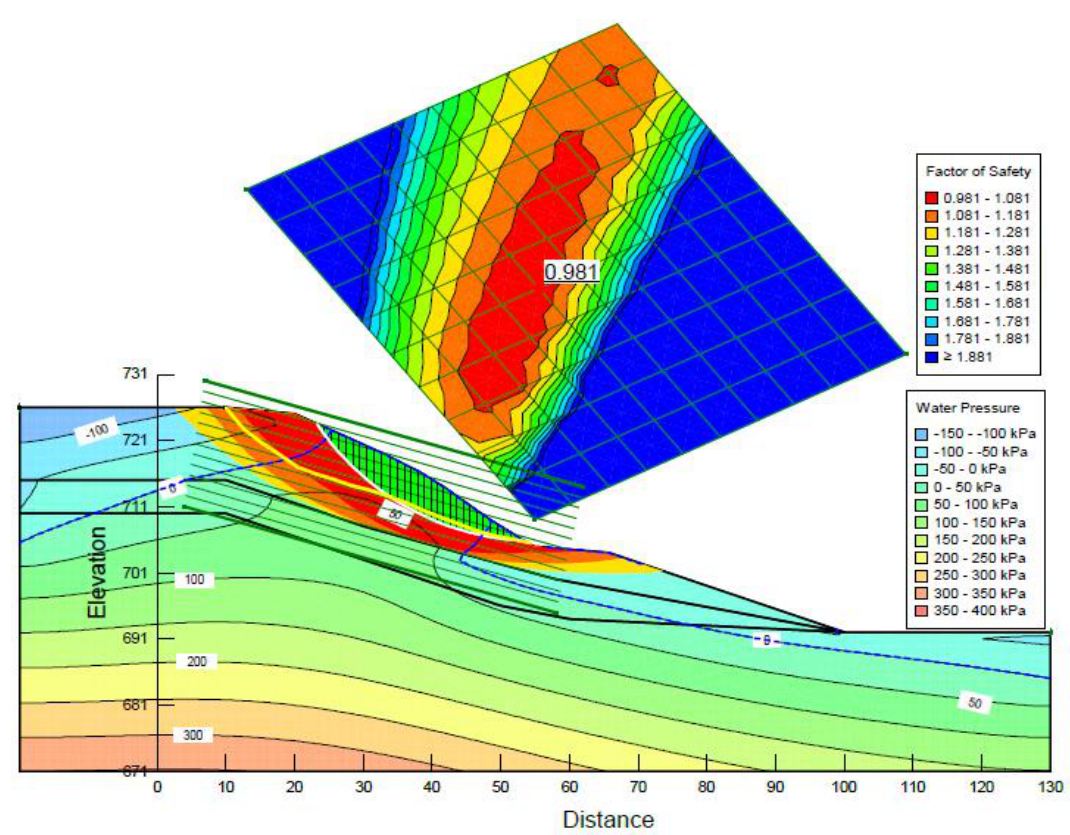
Figure 18. Slope failure after 5.5 h with a flux of 144 mm/day without overtopping.